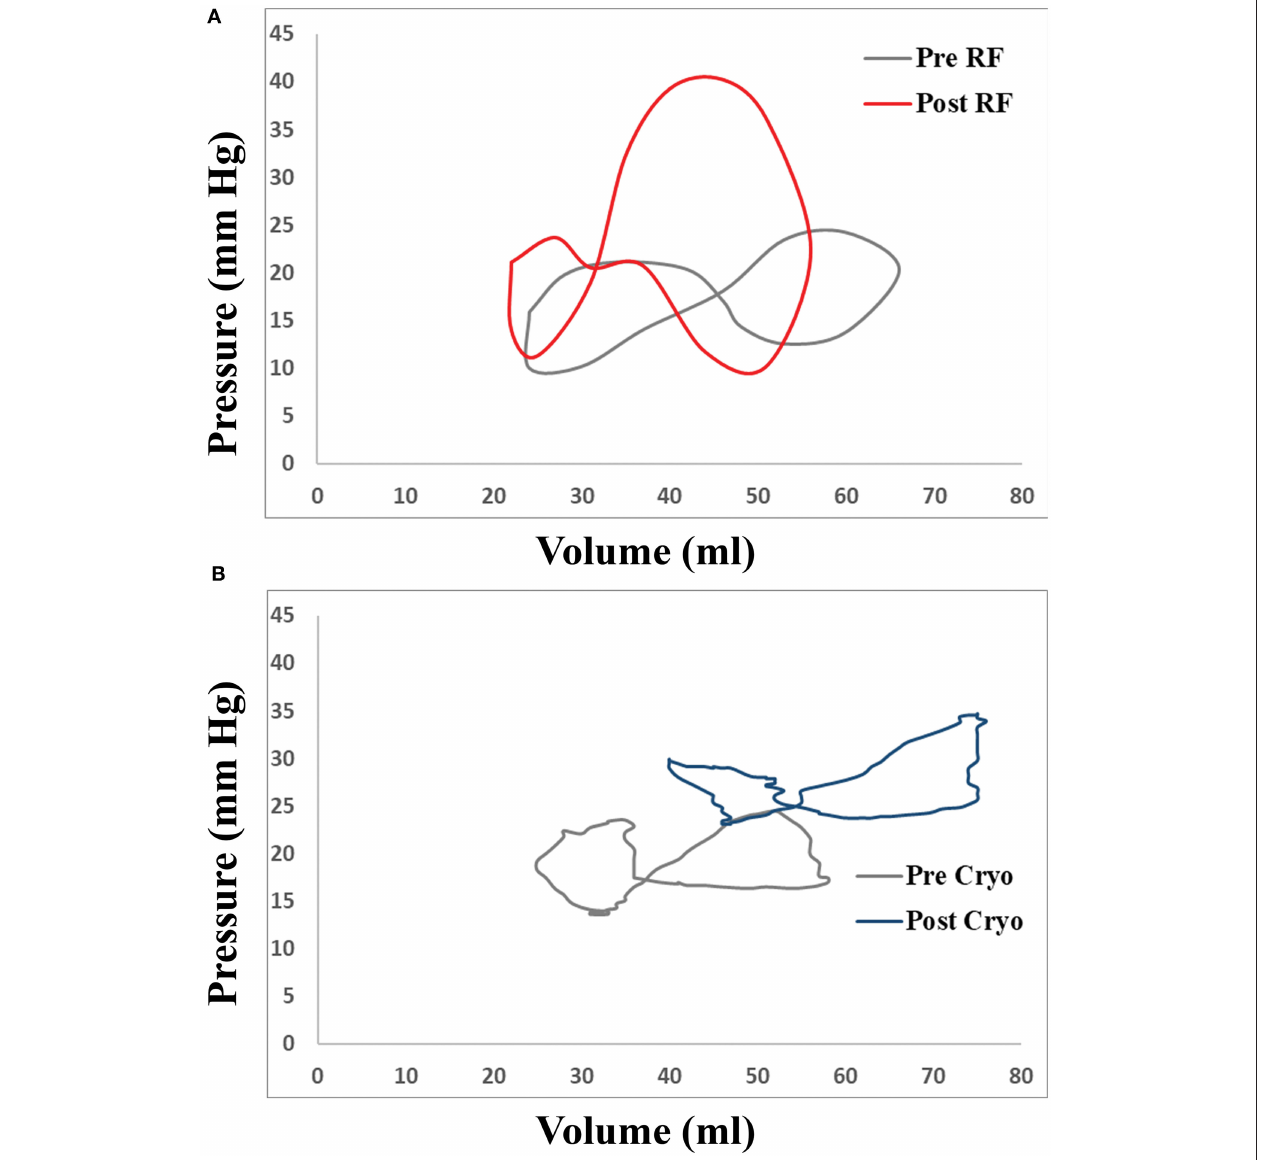
FIGURE 3 | Representative examples of changes in LA volume-pressure loops in patients undergoing transcatheter atrial fibrillation (AF) ablation with (A) radiofrequency catheter and (B) cryoballoon.